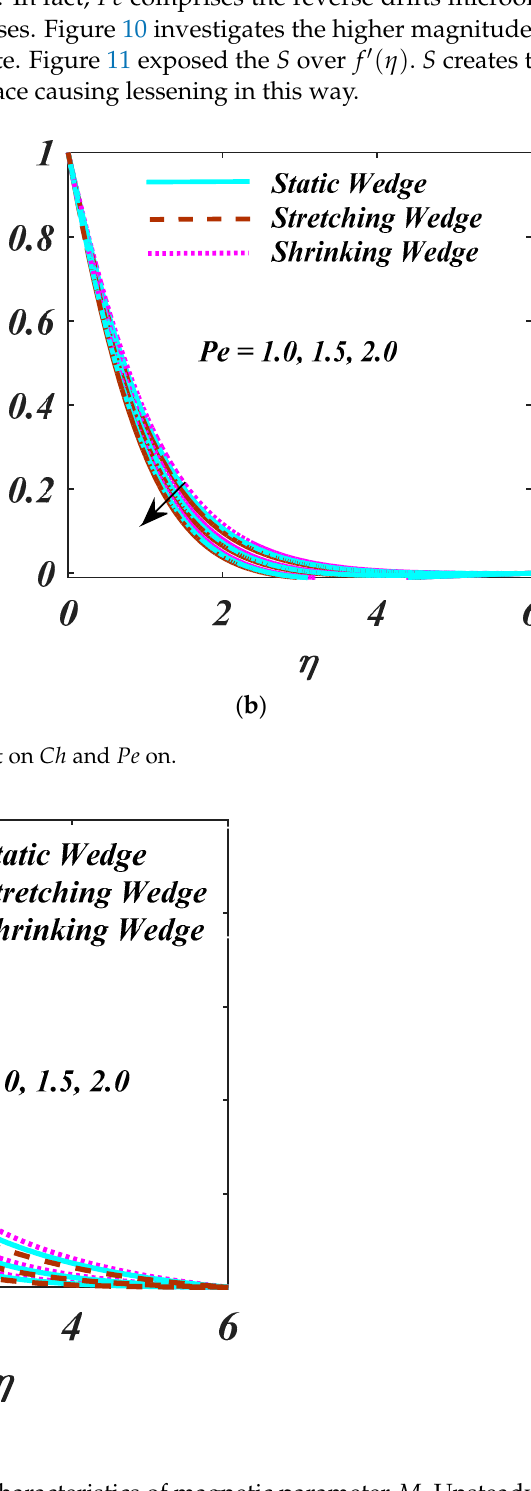
Figure 11. Plot of (cid:1845) on (cid:1858)′(cid:4666)(cid:2015)(cid:4667). Figure 12 demonstrates the characteristics of magnetic parameter (cid:1839) , Unsteady pa ‐ rameter (cid:2013) , Darcy parameter (cid:1832)(cid:1870) , Porosity parameter (cid:2018) and fluid parameter (cid:1849) on the (cid:1829)(cid:1858) (cid:3051) (cid:1844)(cid:1857) (cid:3051)(cid:2869)/(cid:2870) , The (cid:1829)(cid:1858) (cid:3051) (cid:1844)(cid:1857) (cid:3051)(cid:2869)/(cid:2870) is an increasing function of (cid:1849) . The influence of (cid:1844)(cid:1856) (cid:1853)(cid:1866)(cid:1856) (cid:2010) on (cid:1840)(cid:1873)(cid:1844)(cid:1857) (cid:3051)(cid:2879)(cid:2869)/(cid:2870) is explained in Figure 13. Heat transport decline with larger values of (cid:1839) and (cid:2010) . Figure 14 offers the effects of (cid:1829)(cid:1860), (cid:1845)(cid:1855), (cid:1840)(cid:1872), (cid:1840)(cid:1854), (cid:2010) and (cid:2013) for (cid:1844)(cid:1857) (cid:3051)(cid:2879)(cid:2869)/(cid:2870) (cid:1845)(cid:1860) . (cid:1829)(cid:1860) and (cid:2010) have a positive influence for (cid:1844)(cid:1857) (cid:3051) (cid:2879)(cid:2869)/(cid:2870) (cid:1845)(cid:1860). The (cid:4666)(cid:1844)(cid:1857) (cid:3051) (cid:2879)(cid:2869)/(cid:2870) (cid:1840)(cid:1860) ) on the surface is shown in Figure 15 which shows the effects of (cid:1842)(cid:1857), (cid:1838)(cid:1854), (cid:2013) and (cid:2040) . This graph depicts that the motile density drops with growing values of (cid:1842)(cid:1857) . Figure 16a–c depicts a fascinating enactment of the streamline in the actuality of (cid:2019) (cid:3404) 0 , (cid:2019) (cid:3407) 0 and (cid:2019) (cid:3408) 0 . The arrangements portray that the streamlining is more manifest and split into three segments. The pattern is very simple and follows the flow field.